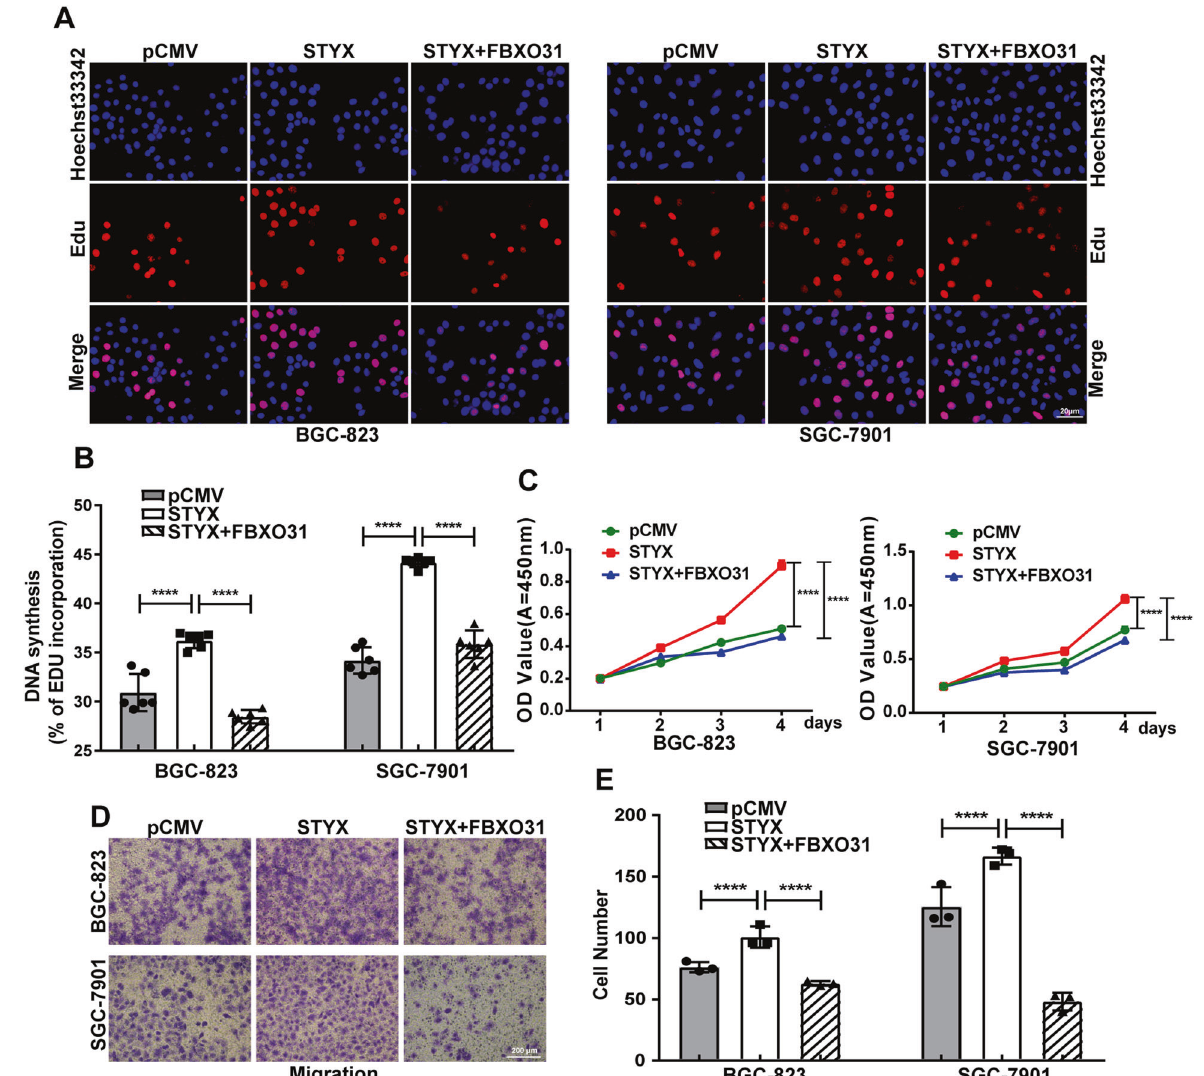
Fig. 7 STYX-mediated promotion of GC cells proliferation and migration can be abrogated by FBXO31. A EdU analysis of the cell proliferation ability in GC cells with different transfection. The representative results were showed. B Statistical analysis of the EdU-positive cell ratio in transfected GC cells. The data are expressed as the means ± SD from six independent experiments. C CCK-8 analysis of the cell proliferation ability in transfected GC cells. The data are expressed as the means ± SD from three experiments. D Transwell invasion and migration assay in transfected GC cells. E Statistical analysis of the cell numbers passing through the transwell fi lter in GC cells. The data are expressed as the means ± SD from three experiments. The data shown in B and E were analyzed using GraphPad Prism v7.0 4 software with a nonpaired Student t -test. The data shown in C were analyzed using a two-way ANOVA test. ** p < 0.01; *** p < 0.001; **** p <